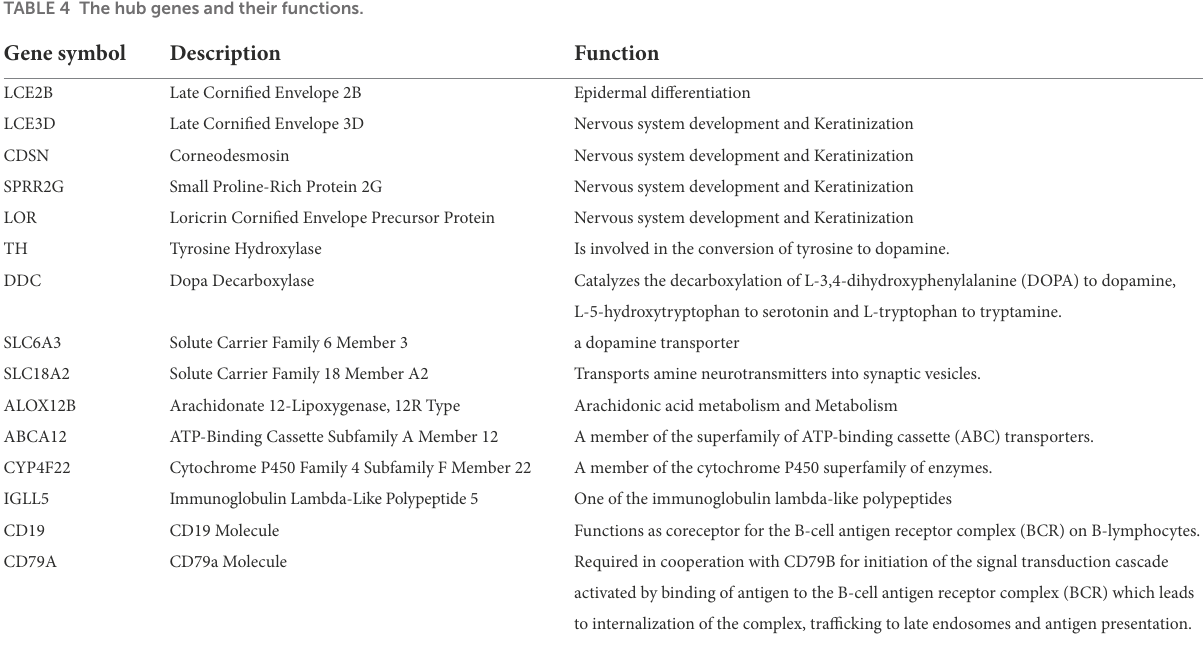
TABLE 4 The hub genes and their